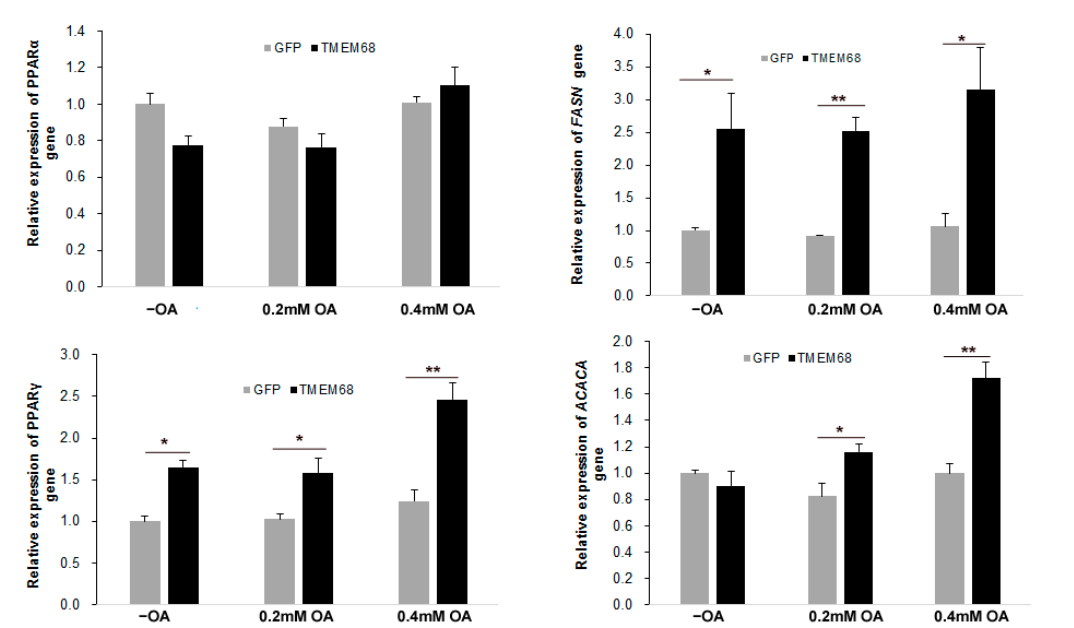
Figure 10. The expression of lipogenesis genes altered by TMEM68 overexpression. 293/GFP and 293/TMEM68 cells were incubated with OA at the indicated concentrations or not ( − OA) for 12 h, and total RNA was then prepared and reverse transcribed to cDNA. mRNA levels were quantified by qPCR normalized to β -actin as an internal reference gene that were presented as fold change of 293/GFP cells without OA treatment. Data are presented as means ± SD. p values were shown by asterisk: * p < 0.05, ** p < 0.01, n = 6.